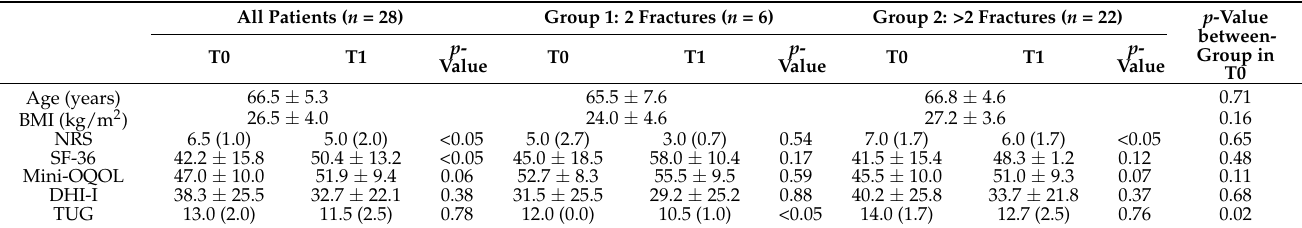
Table 1. Baseline characteristics and values of clinical outcome measures before and after treatment. All Patients ( n = 28)